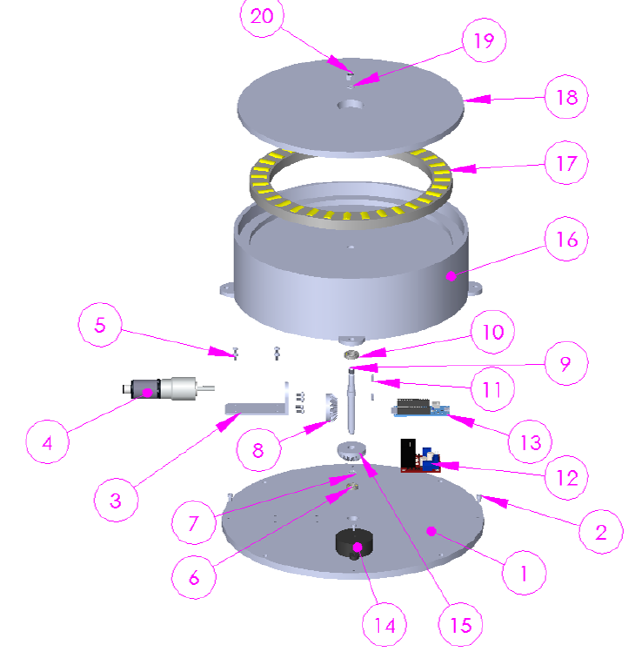
Figure 22. Exploded view of the mechatronic interface: ( 1 ) Mounting plate; ( 2 ) Screws UNI 5931- M3x5-8.8; ( 3 ) Motor bracket; ( 4 ) DC Motor-gearbox-encoder; ( 5 ) Screws DIN EN ISO 7045-M3x6-4.8; ( 6 ) Bearing SKF 618/6; ( 7 ) Seeger circlip DIN 471 φ 8; ( 8 ) KHK LM 1.5-20 bevel gear φ 8; ( 9 ) Shaft; ( 10 ) Bearing SKF 618/8; ( 11 ) Key UNI 6604-A 2x2x6; ( 12 ) Motor driver L298N; ( 13 ) Arduino MKR 1000; (textbf14) Buzzer KPEG-350; ( 15 ) KHK LM 1.5-20 bevel gear φ 6; ( 16 ) Base; ( 17 ) Bearing SKF 81136M; ( 18 ) Rotating platform; ( 19 ) Washer; ( 20 ) Nut M5 UNI